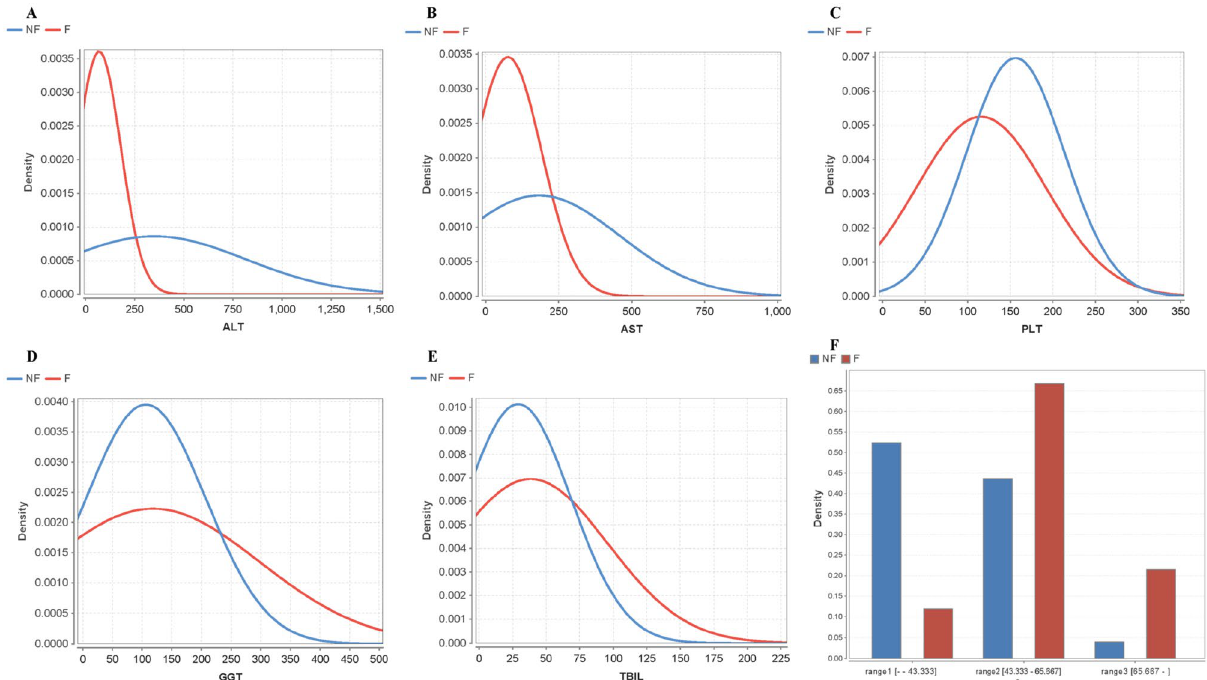
Figure 2. Effect to fibrosis of six main attributes by using optimized Naïve Bayes classifier. ( A – F ) The distribution of ALT, AST, PLT, GGT, TBIL and age related to fibrosis